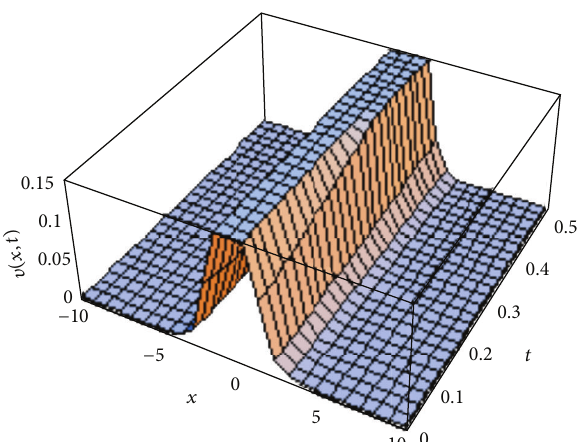
Figure 4: Approximate solution for 𝛼 = 1 and 𝛽 = 1